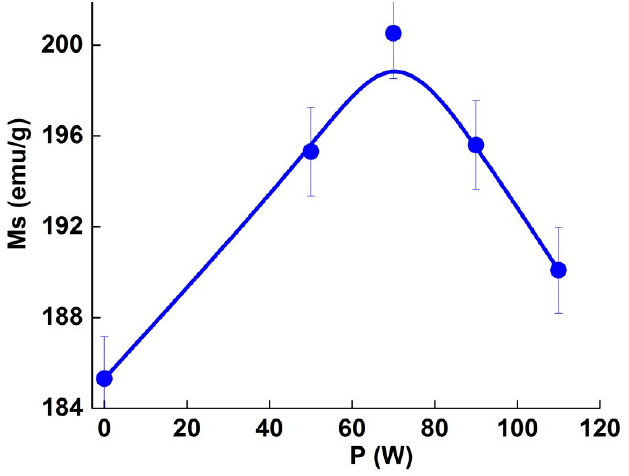
Figure 7. Evolution of the saturation magnetization versus the laser power. The horizontal shift of the M(H) curves can be related to the development of a mag- netically non-homogeneous antiferromagnetic (AFM)/ferromagnetic (FM) matrix, result- ing from the pinning effect at the interface between the soft and hard magnetic substances.